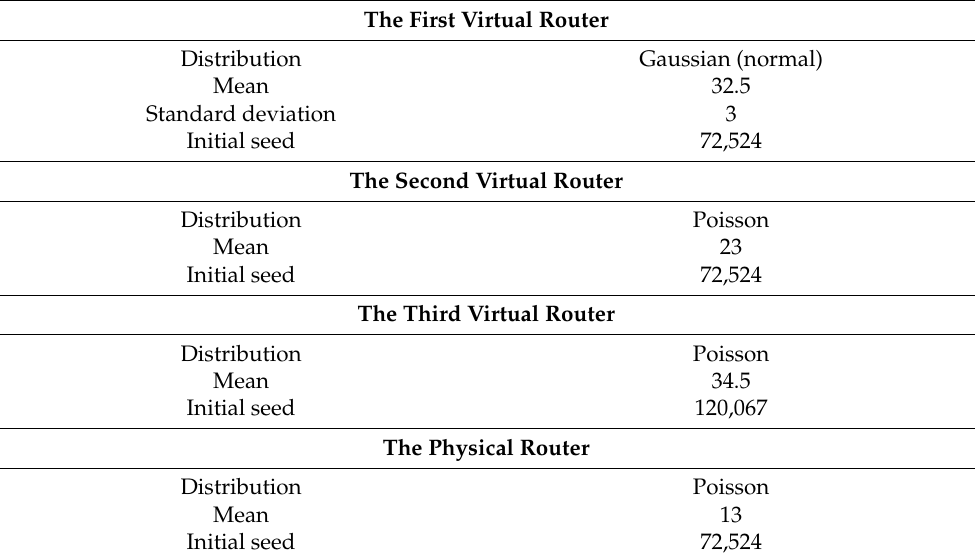
Table 4. Source block parameters for three virtual routers (one router—CPU 450 MHz, two router— CPU 760 MHz, three router—CPU 240 MHz) and one physical router without virtualization (CPU 1400 MHz) for a service time 32.5 µ